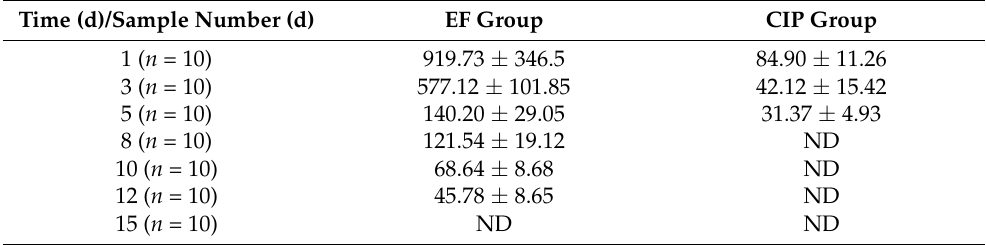
Table 5. Residual concentrations of EF after EF soluble powder in eggs (mean ± SD, n = 10) ( µ